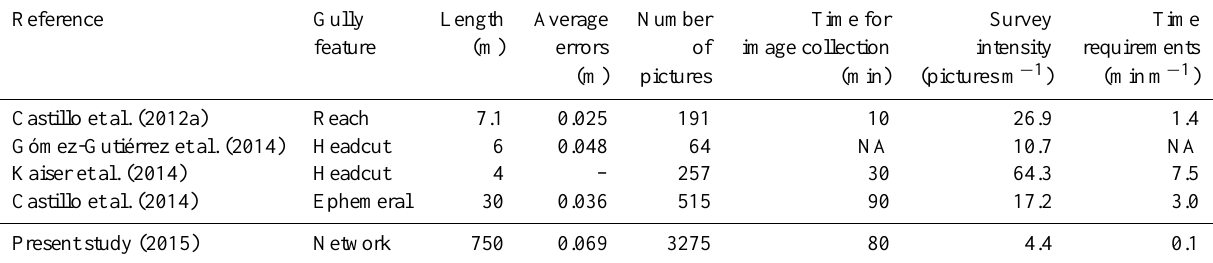
Table 3. Comparison between the survey intensity (number of pictures per metre of gully) and time requirements (image collection time per metre of gully) for different gully erosion studies using SfM photo-reconstruction including the present